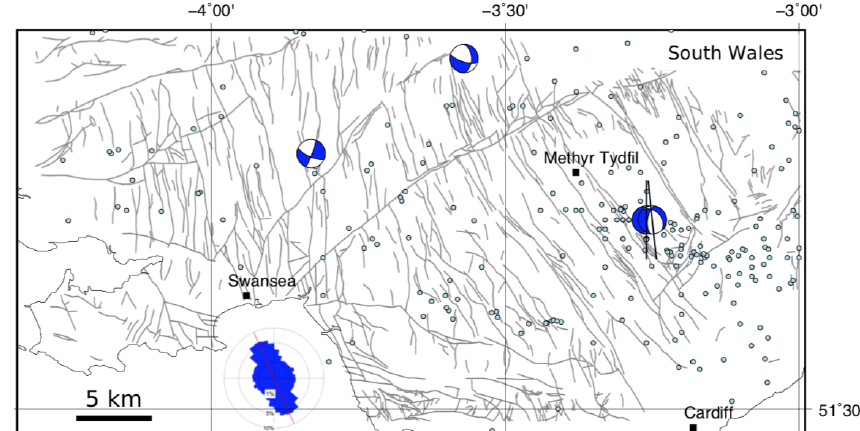
Figure 14. Maps of the South Wales coalfield (a suggested site of shallow mine geothermal energy) showing selected population centres (black squares), epicentres of seismicity (light blue dots; BGS catalogue; Musson, 1996), focal mechanisms (blue and white; Baptie, 2010), and orientations of the maximum horizontal stress (black lines; World Stress Map data; Heidbach et al., 2018). Inset equal-area rose diagrams show orientations of mapped faults. Faults in the Coal Measures taken from the BGS Hydrogeological Map of South Wales (1:125000) ( n = 3408), with a circular mean strike of 156 ◦ and a circular standard deviation of 65 ◦ .